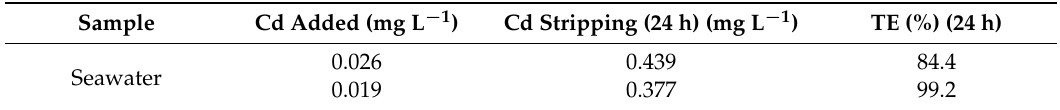
Table 3. Cd transport efficiency from spiked seawater samples using the designed HFSLM